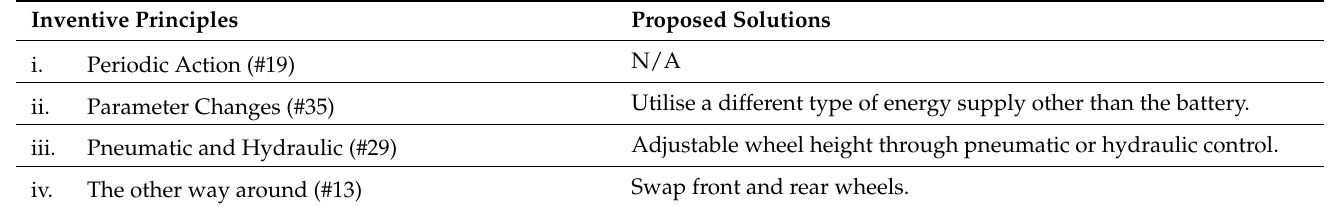
Table 4. Proposed solutions based on principles from parameters #35 and #19 within the contradic- tion matrix.